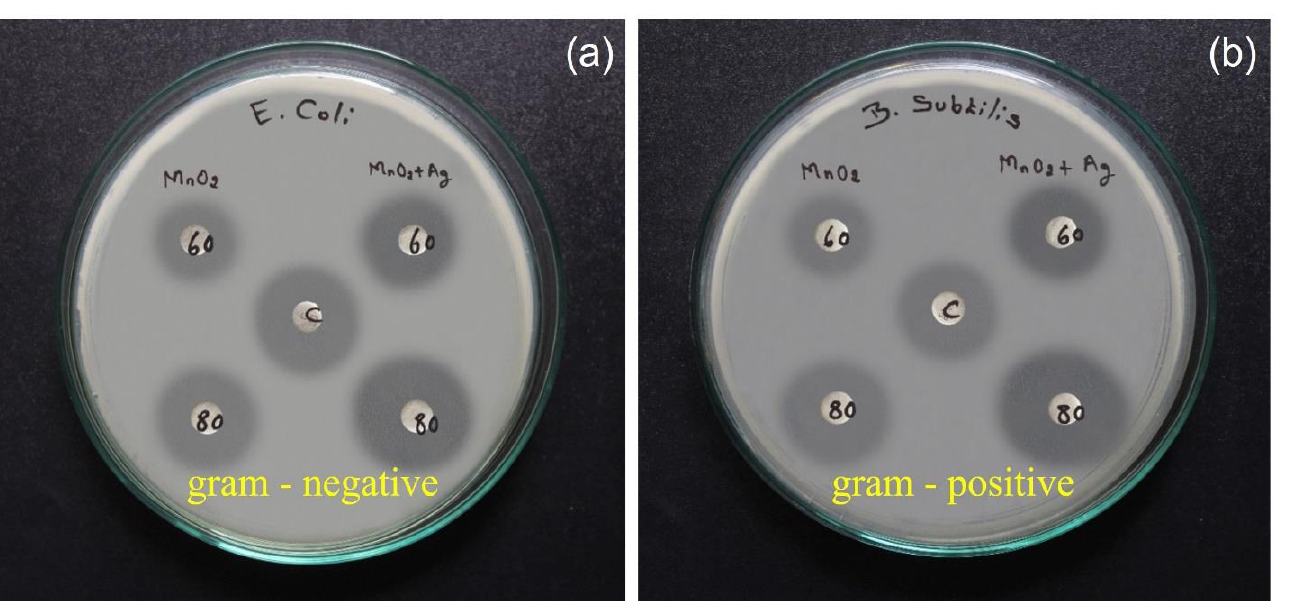
Figure 10. ( a , b ). Antibacterial activity of MnO 2 doped with Ag nanoparticles against Gram-negative ( Escherichia Coli ) and Gram-positive ( Bacillus subtilis ) strains.